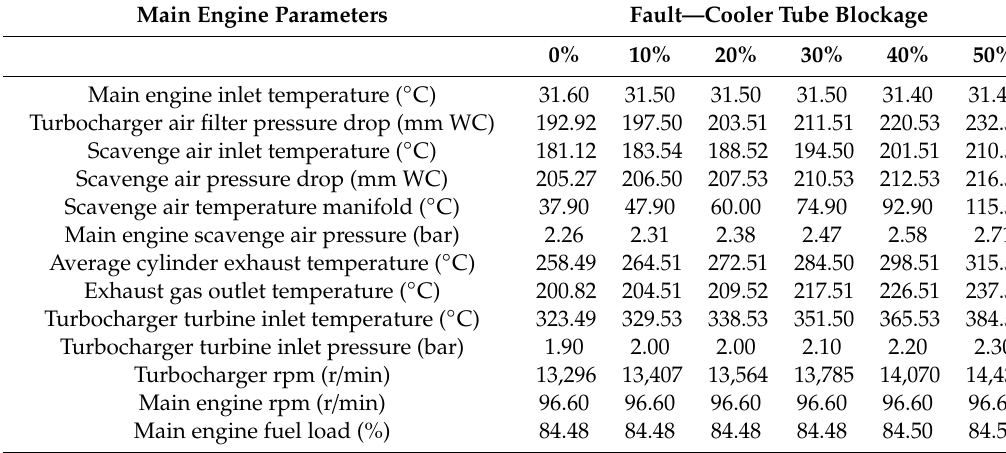
Table 2. Cooler tube